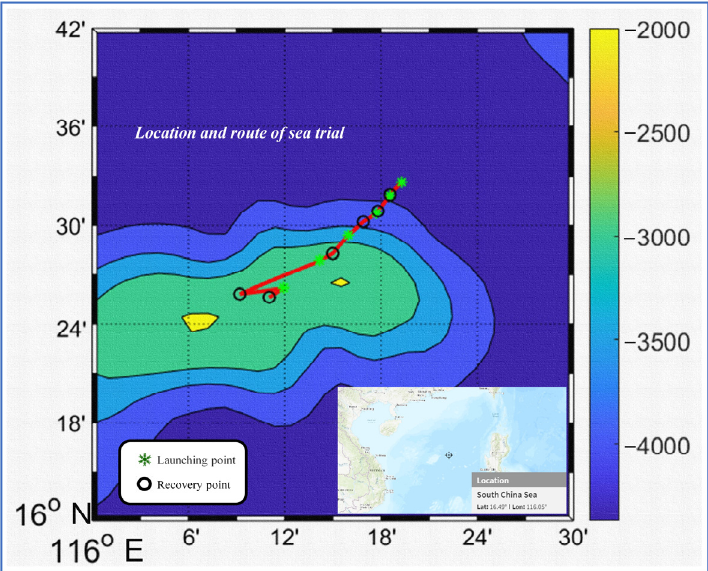
Figure 11. The trajectory of the thermal energy power generation module in sea trial.